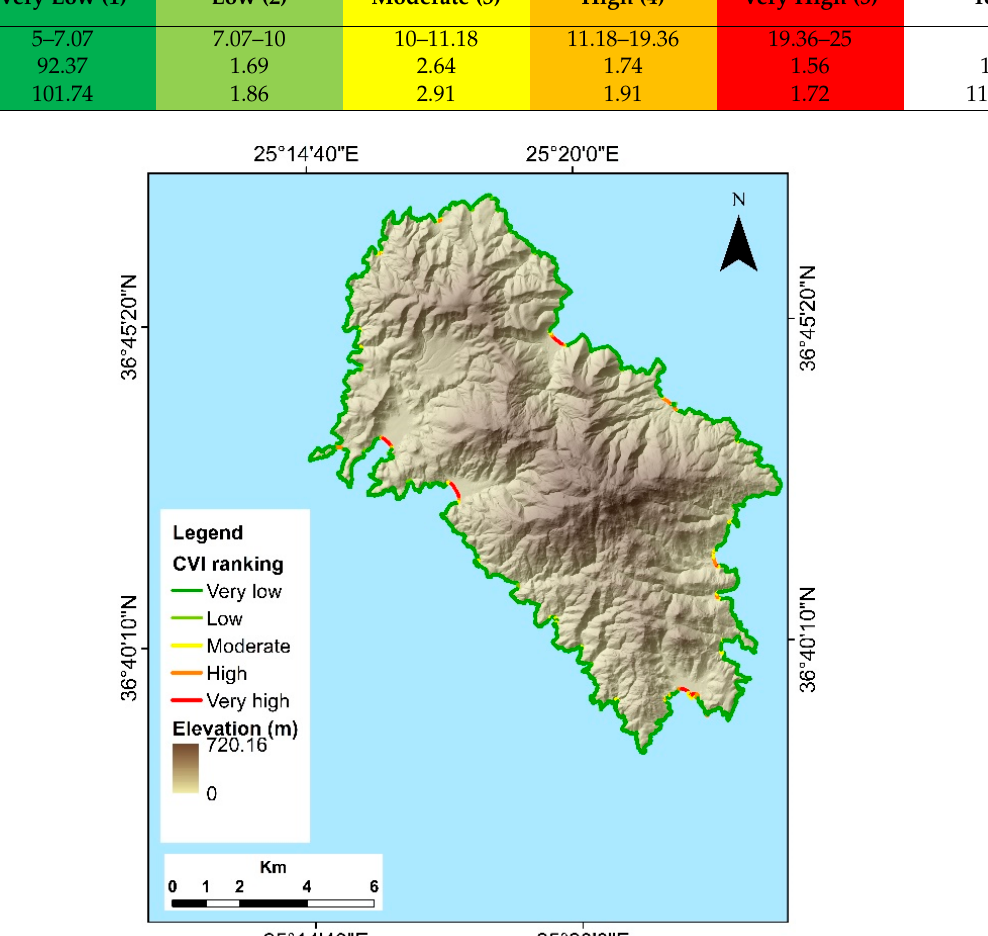
Figure 8. Map of vulnerability ranking of the CVI values. Table 4. Ranking of the CVI values. The table indicates the length, in km and percentage, of coastline in each category of vulnerability.